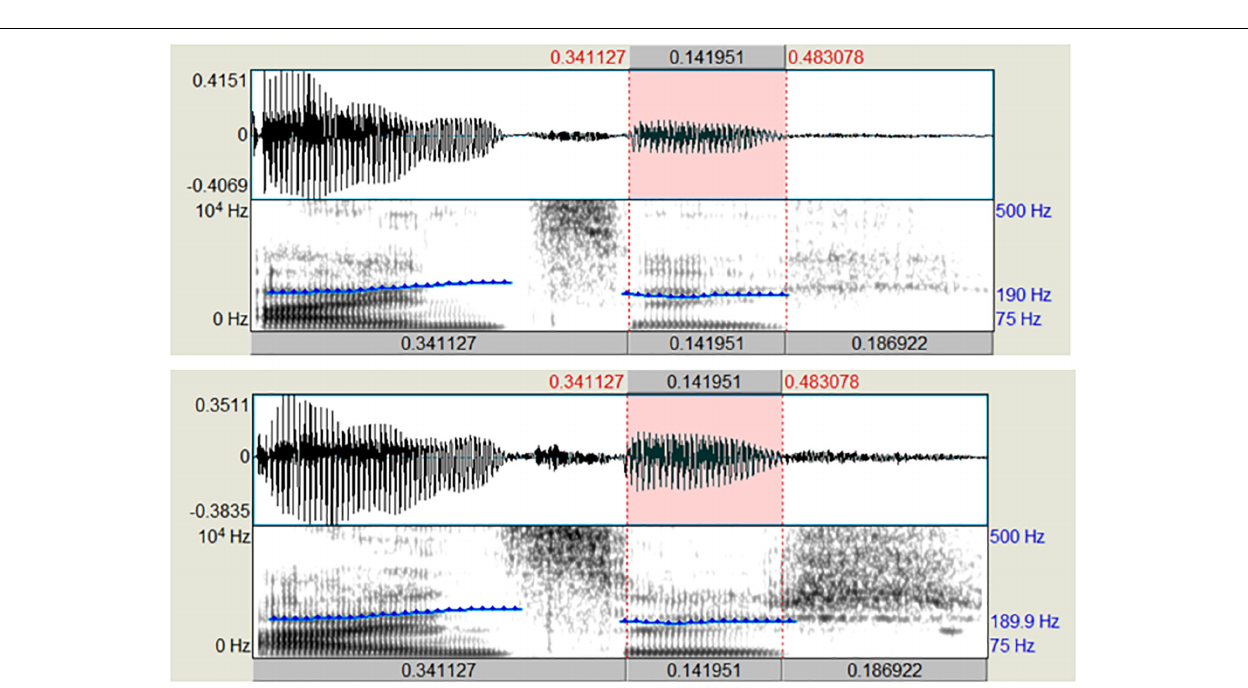
FIGURE 3 | (Left plot) Spectral shape of the two fricatives in / n ʊ .s ɪ ç / (black) and / n ʊ .s ɪɕ / (blue). (Right plot) Distribution of CoG values separated by canonical (black) and non- canonical (blue) stimuli.